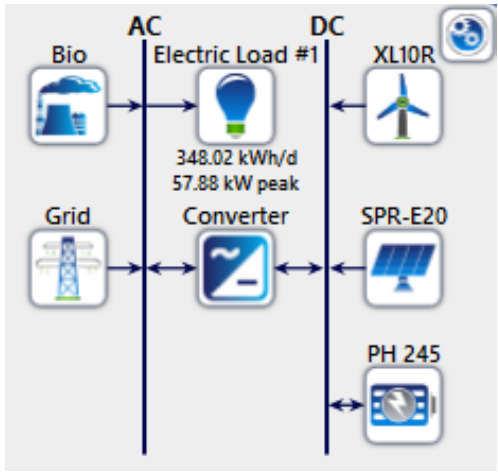
Figure 6. The proposed hybrid system in Hybrid Optimization of Multiple Energy Resources (HOMER).